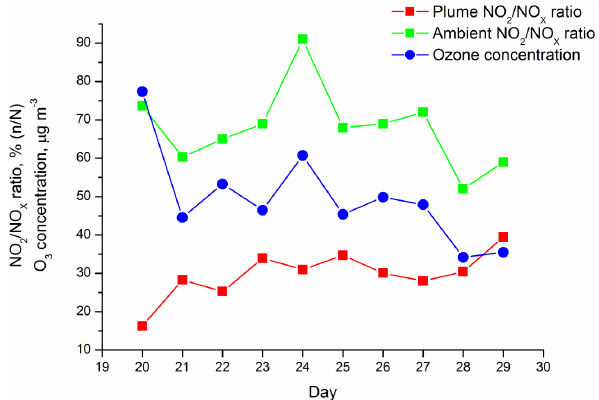
Fig. 18. Diurnal averages of ambient and plume NO 2 /NO x molar Figure 18. Diurnal averages of ambient and plume NO 2 /NO X molar ratios and ozone 1054 ratios and ozone concentrations during the measurement campaign. concentrations during the measurement campaign. Concentration data between 8:00 1055 Concentration data between 8.00 and 20.00 were concerned for the and 20:00 were concerned for the averaging. 1056